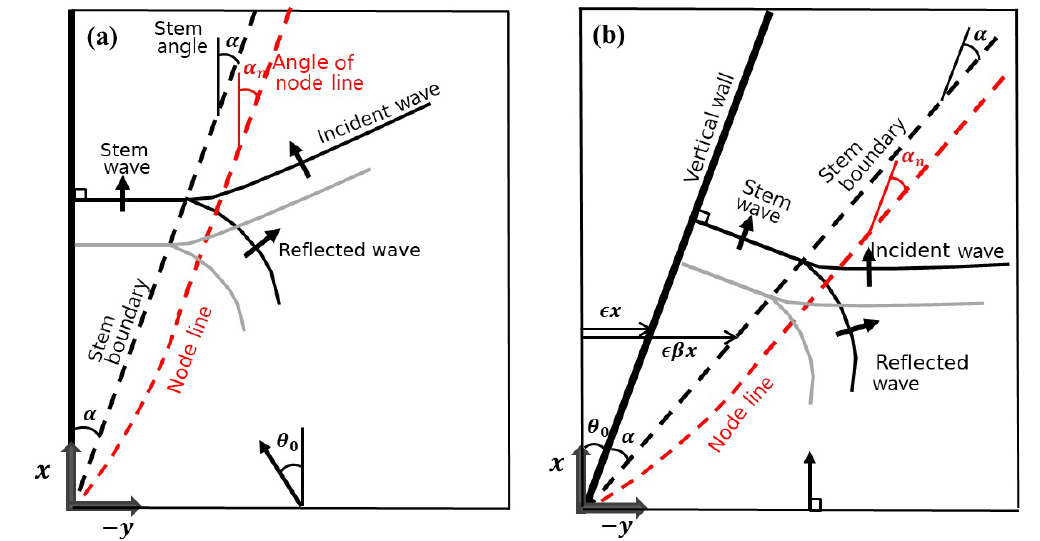
Figure 2. Coordinate system for numerical simulations: (a) present, (b) Yue and Mei